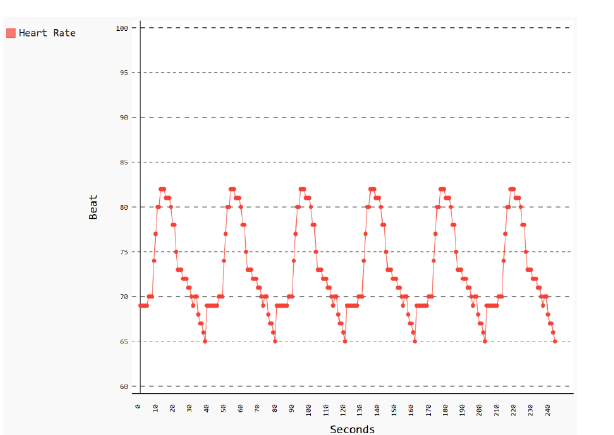
Fig. 7. Oxygen Saturation Data.